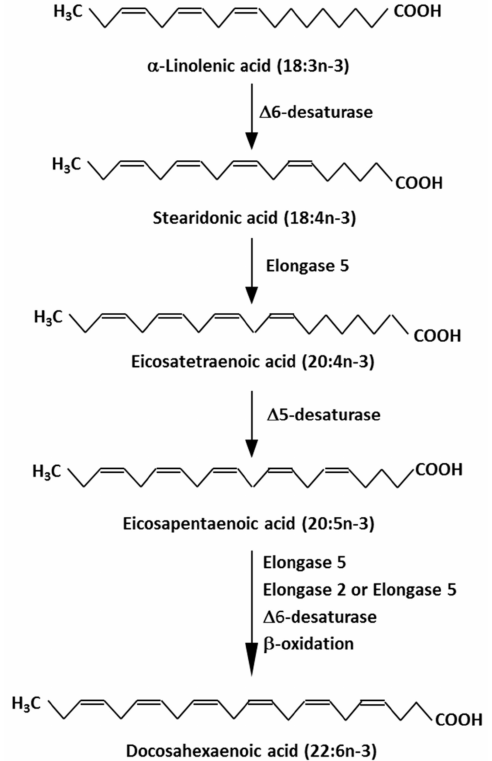
Figure 1. Metabolic pathway of conversion of the plant essential n-3 fatty acid, α -linolenic acid (18:3n-3), to eicosapentaenoic acid (20:5n-3) and docosahexaenoic acid